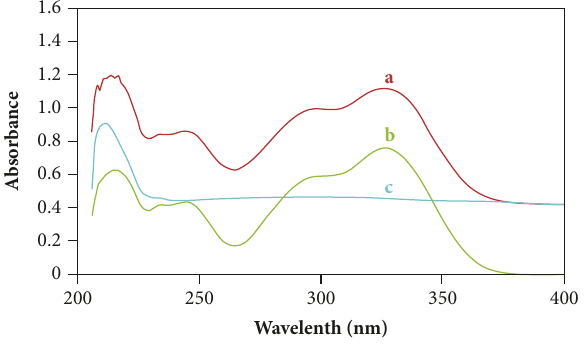
Figure 8: The absorbance peaks of the catalyst measured by UV spectrophotometer. (a) CNTs/CA. (b) CA. (c) CNTs.